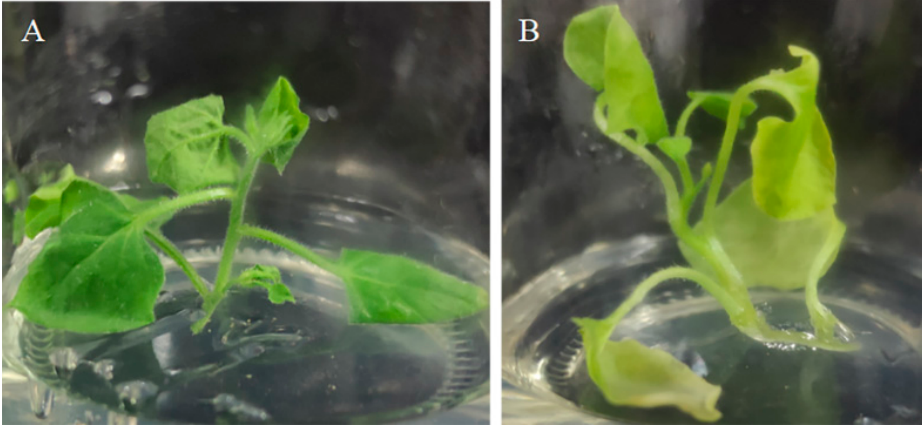
Figure 3. The wild type ( A ) and pTCK303- AbHemA2- RNAi transgenetic plants ( B